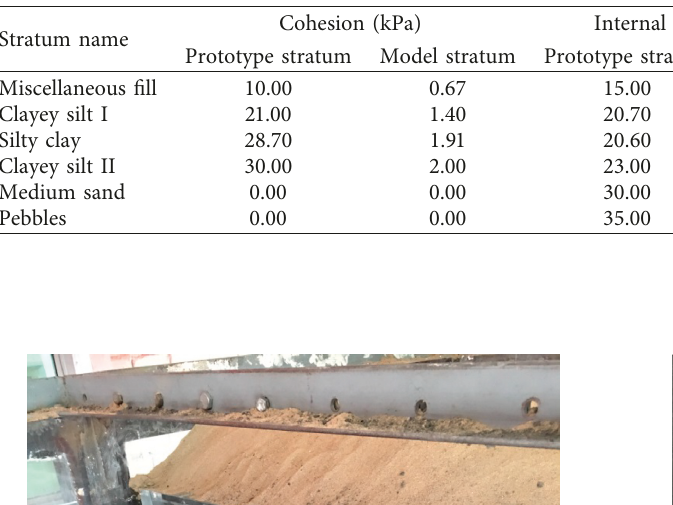
Table 4: Parameters of prototype and model strata.